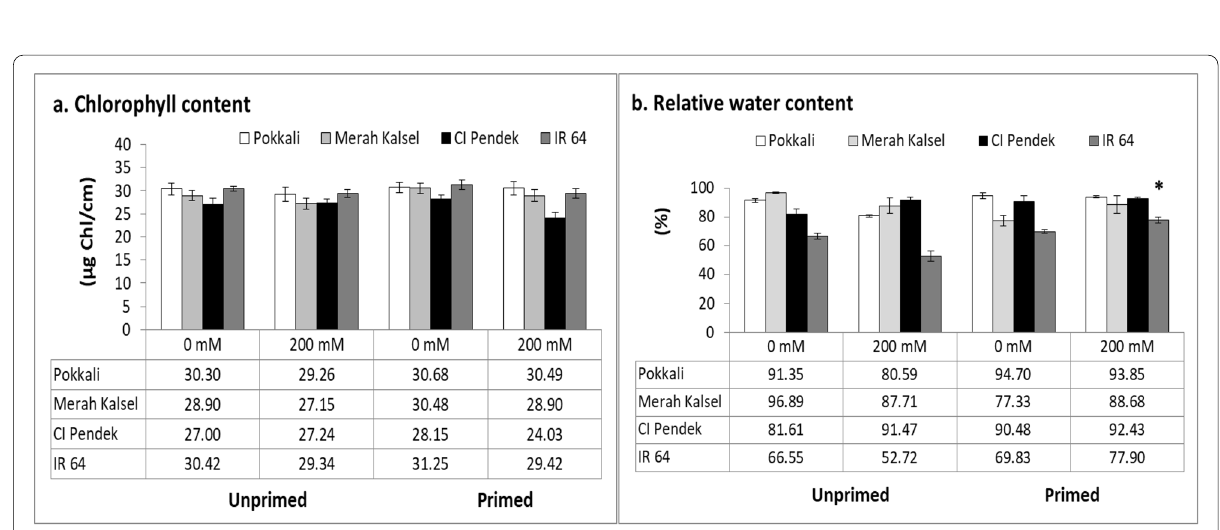
Fig. 2 Effect of salinity stress on agronomic parameters of rice plants. a Chlorophyll content, b relative water content (RWC). Chlorophyll contents were measured for 7 days after salinity treatment; relative water content in the whole plant with and without priming was measured 7 days after salinity stress. Values are means of three replicates SE. * p < 0.05, ** p < 0.01, LSD ±